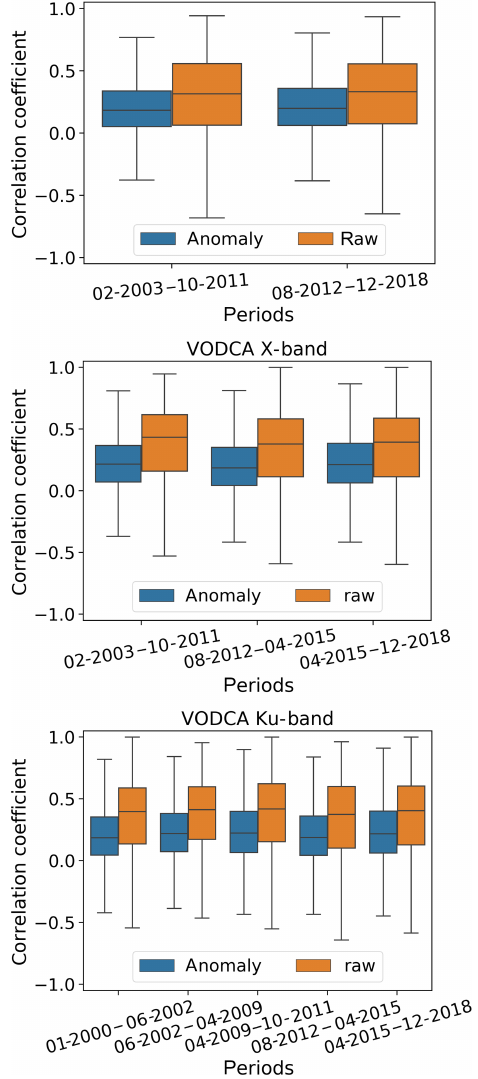
Figure 7. Correlation between VODCA and MODIS LAI, raw time series, and anomalies, for different blending periods.